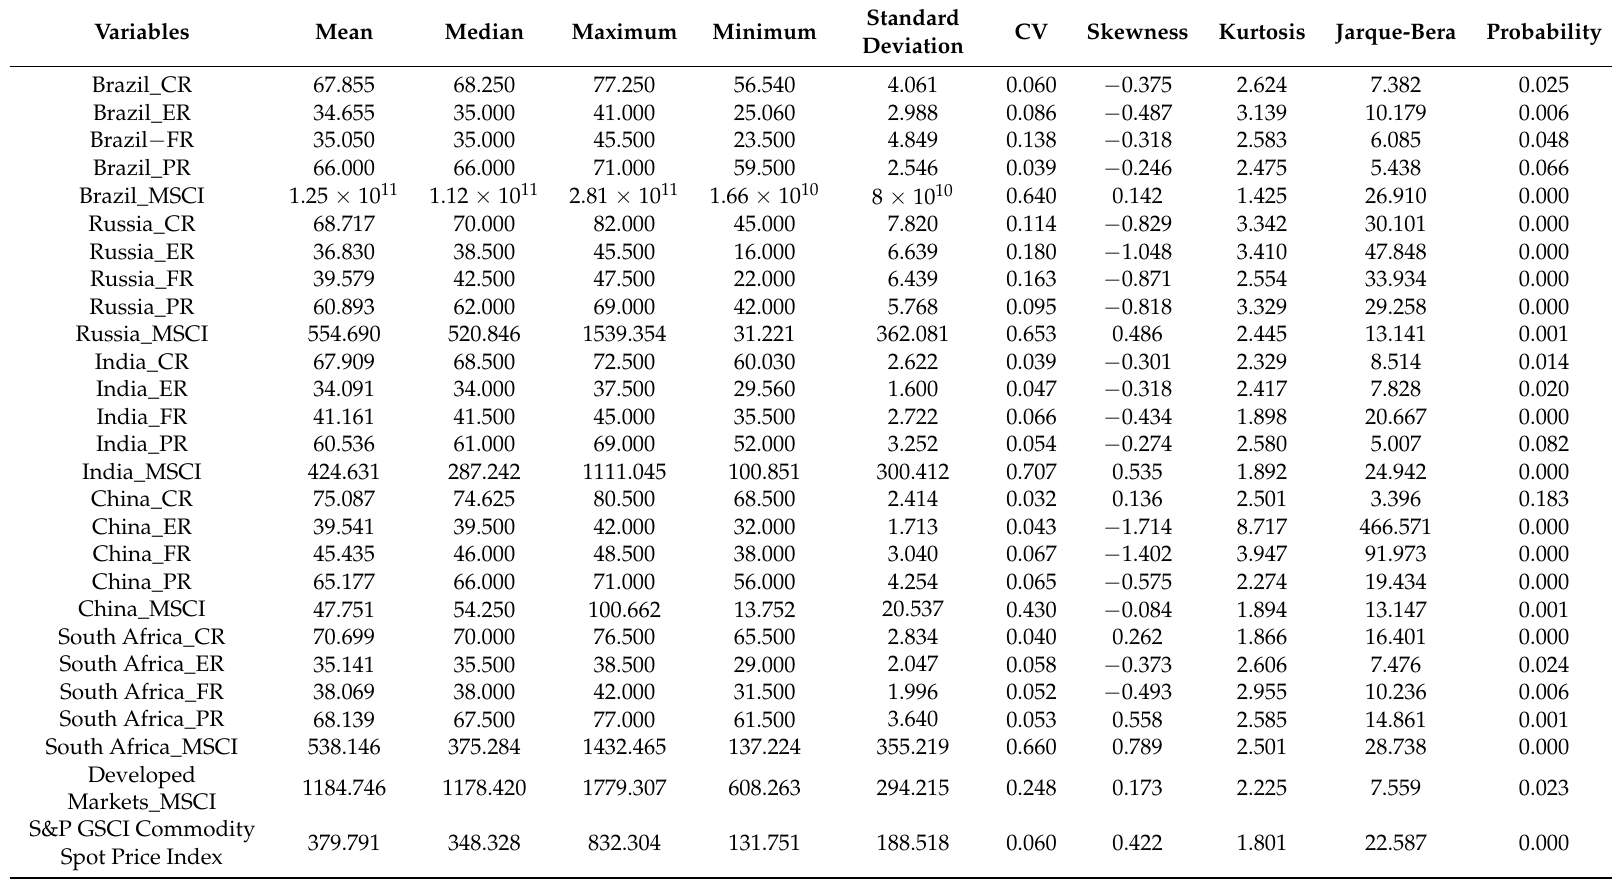
Table A1. Summary Statistics for country